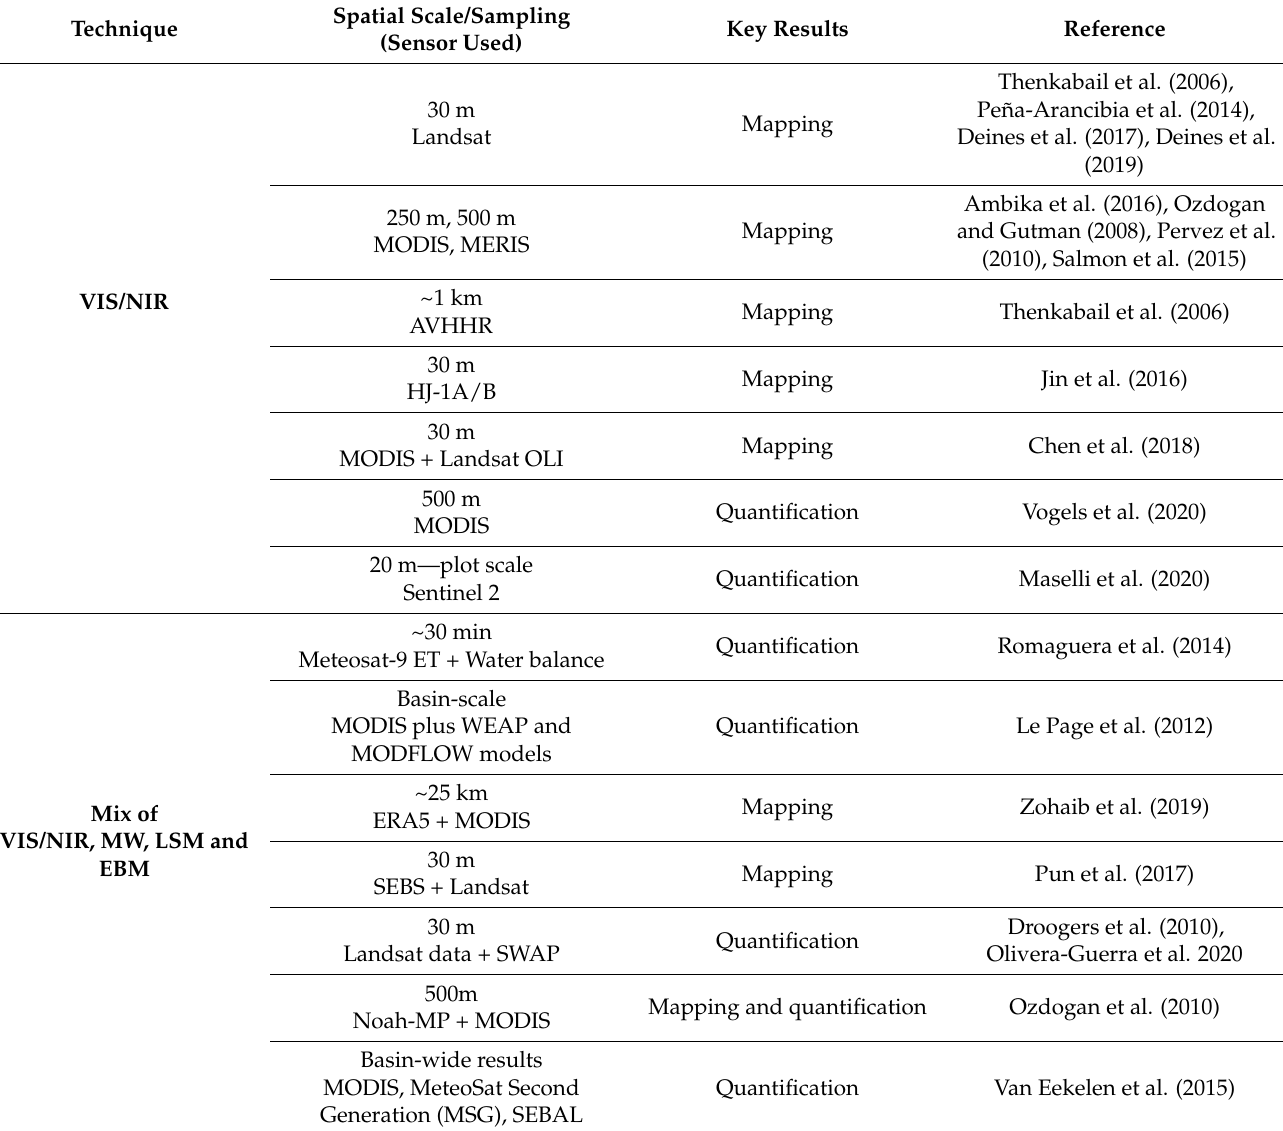
Table 1. Summary of relevant literature on the irrigation detection and quantification using satellite amount. Key results indicate the ability of the technique to map (“mapping”, i.e., detect irrigated areas) and quantify applied irrigation volumes (“quantification”). The technique column indicates the main method used among visible- and near-infrared sensors (VIS/NIR), Microwave (MW), Land Surface models (LSM), and Energy balance models (EBM).